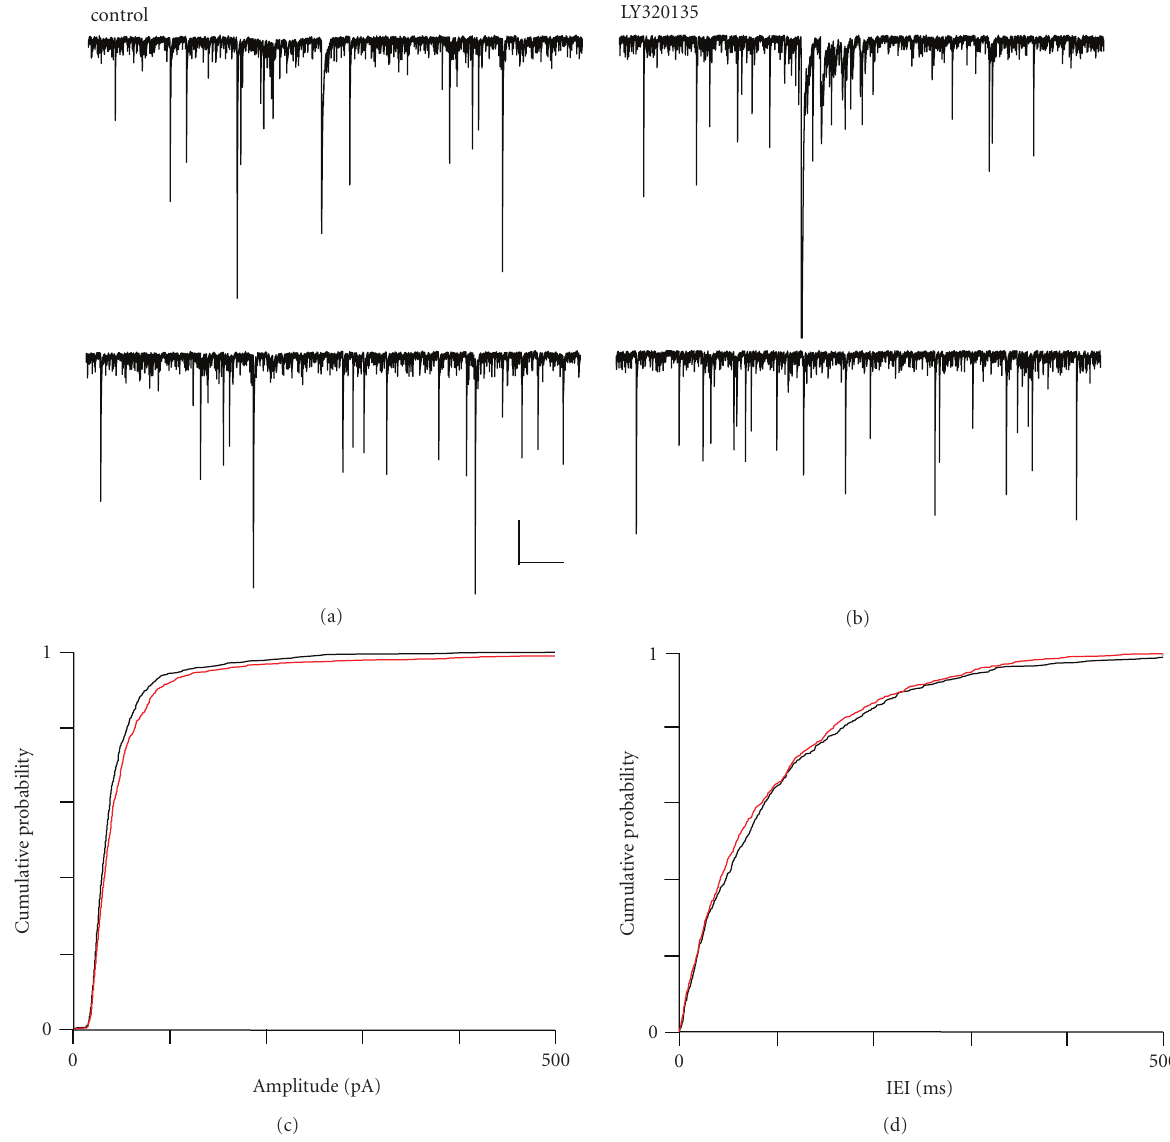
Figure 7: The e ff ects of LY320135 on sIPSCs in mEC layer II. (a) Recording from a layer II neurone under control conditions and (b) in the presence of LY320135 (500 nM). (c) Cumulative probability plot for sIPSC amplitude under control (black) and LY320135 (red) conditions. (d) Cumulative probability plot for sIPSC IEI under control (black) and LY320135 (red) conditions. Scale bars 500 milliseconds × 250pA.